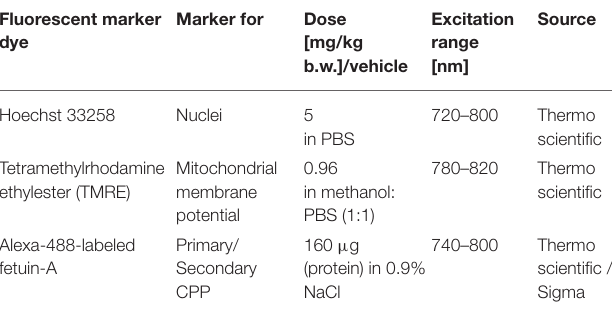
TABLE 1 | Fluorescent marker dyes and imaging conditions. Fluorescent marker Marker dye